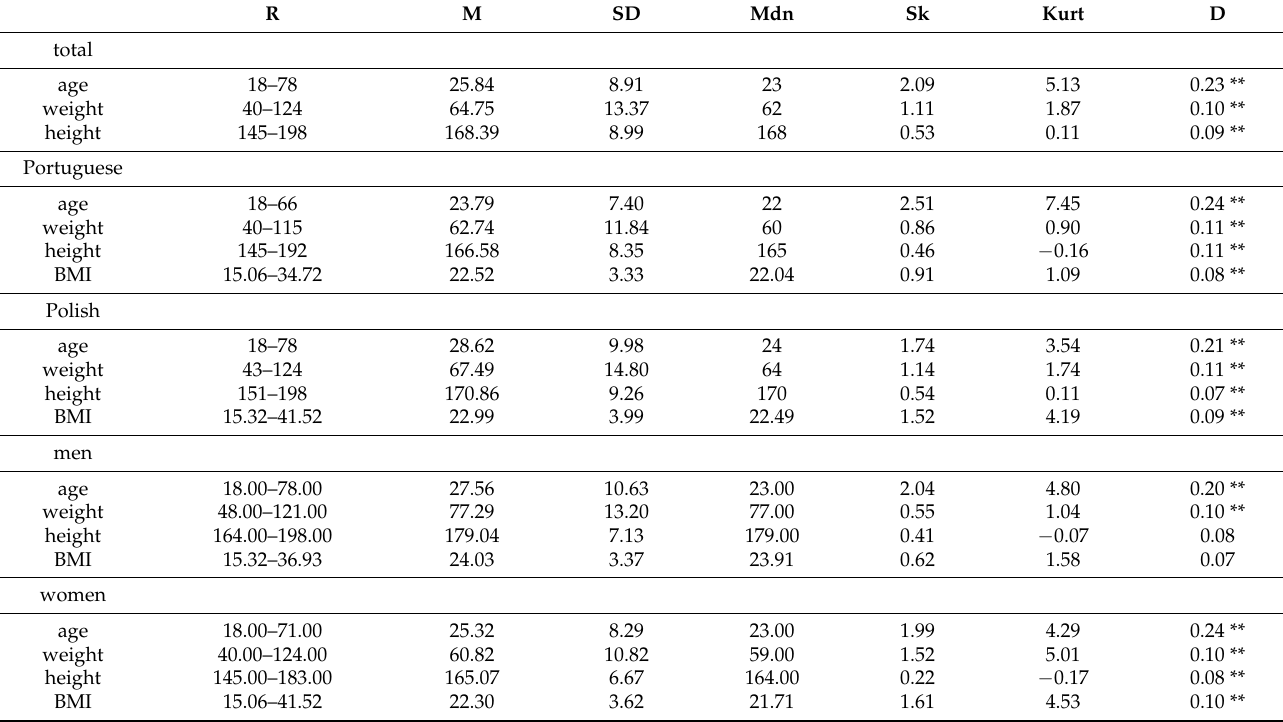
Table 1. Descriptive statistics for demographic variables of the sample (N =